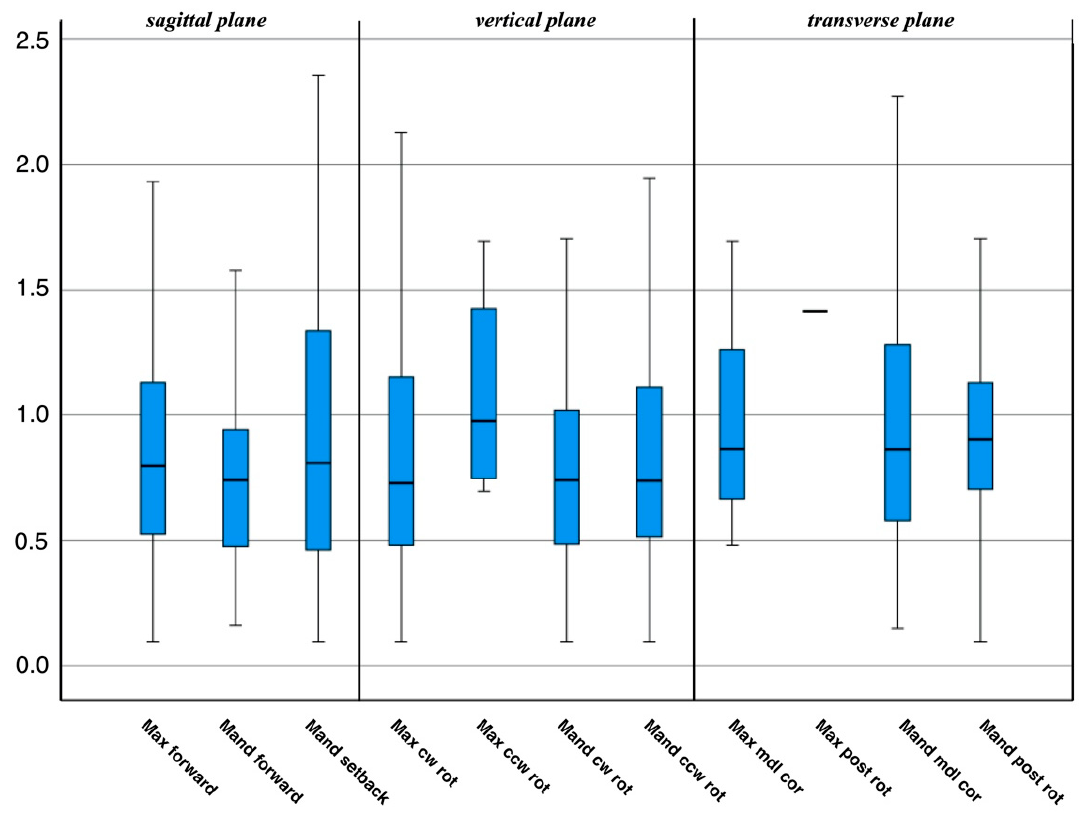
Figure 2. Three-dimensional distances between virtual planning and postoperative outcome categorized according to surgical movements and spatial planes. Less accurate movements are mandible back, maxilla posterior down, and all movements in the transverse plane. Abbreviations: cw, clockwise; rot, rotation; ccw, counterclockwise; mdl, midline; cor, correction; post, posterior